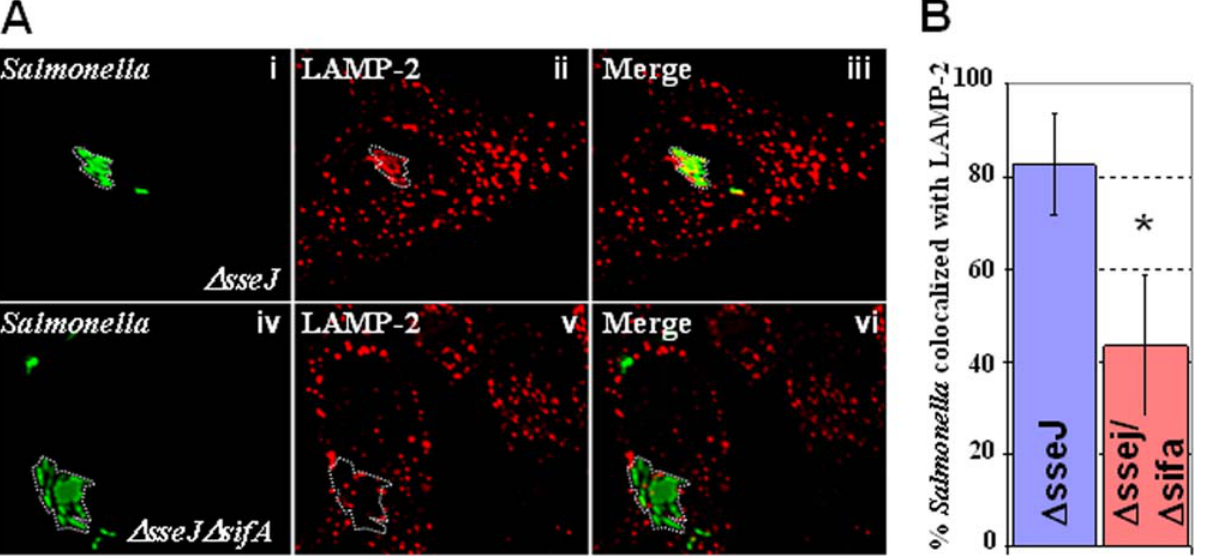
Figure 2. LAMP-2 recruitment is mediated by SifA. A. HeLa cells were infected with D sseJ (i–iii) or D sseJ / D sifA (iv–vi) mutants (green). 18 hours post-infection, the monolayers were fixed and imunno-stained for LAMP-2 (red). D sseJ bacteria colocalize with LAMP-2 (i–iii). D sseJ/ D sifA mutants (green; iv–vi), show significantly reduced co-localization with LAMP-2. B. Volocity image analysis software was used to quantitate association of bacteria with LAMP-2 in D sseJ/ D sifA and D sseJ mutants. A two-tailed P value was obtained from the Volocity quantitation using the Student’s T test. The P value is 0.0001 which indicates there is significant difference between the colocalization of LAMP-2 with D sseJ versus D sseJ/ D sifA .